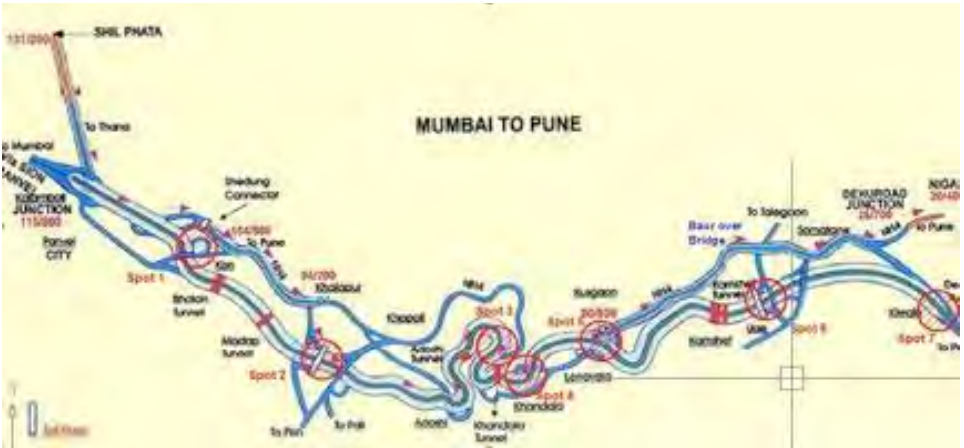
Figures 11: Seven geostress accident spots on Mumbai-Pune Expressway